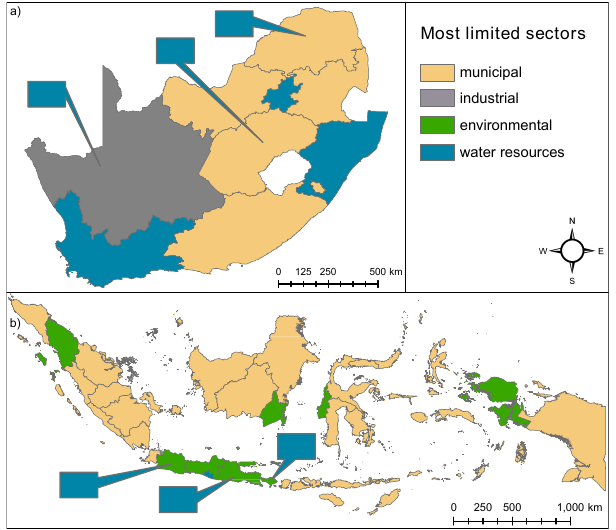
Figure 6. Overview of the most limited sectoral adequacy for the regions of (a) South Africa and (b) Indonesia. Where changes oc- cur across scenarios, these are indicated by a box in the respective colour. Note that the sectoral limitations shown for South Africa are the second-most important after the environmental